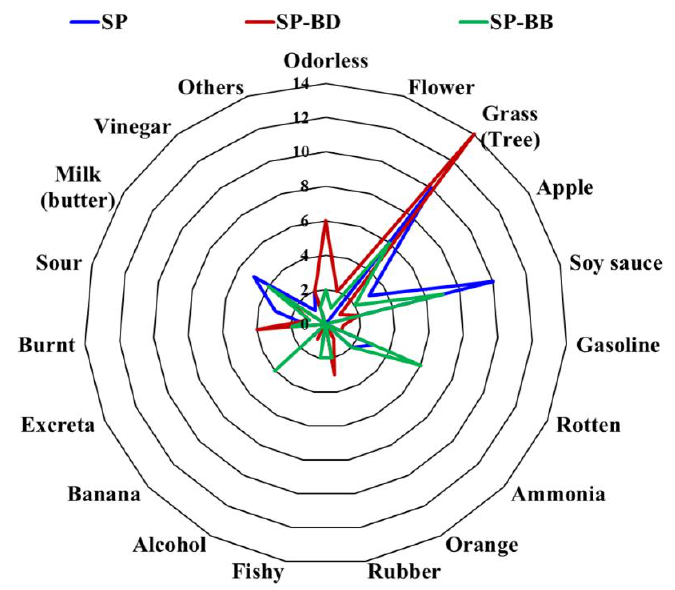
Figure 5. Quantitative descriptive sensory analysis, using 42 panels, for evaluating specific flavors. Results of the sensory perception were filled in with the questionnaire provided. SP, sheep placenta; SP-BD, sheep placenta fermented with B. deamine kh3; SP-BD, sheep placenta fermented with B. bruxellensis .